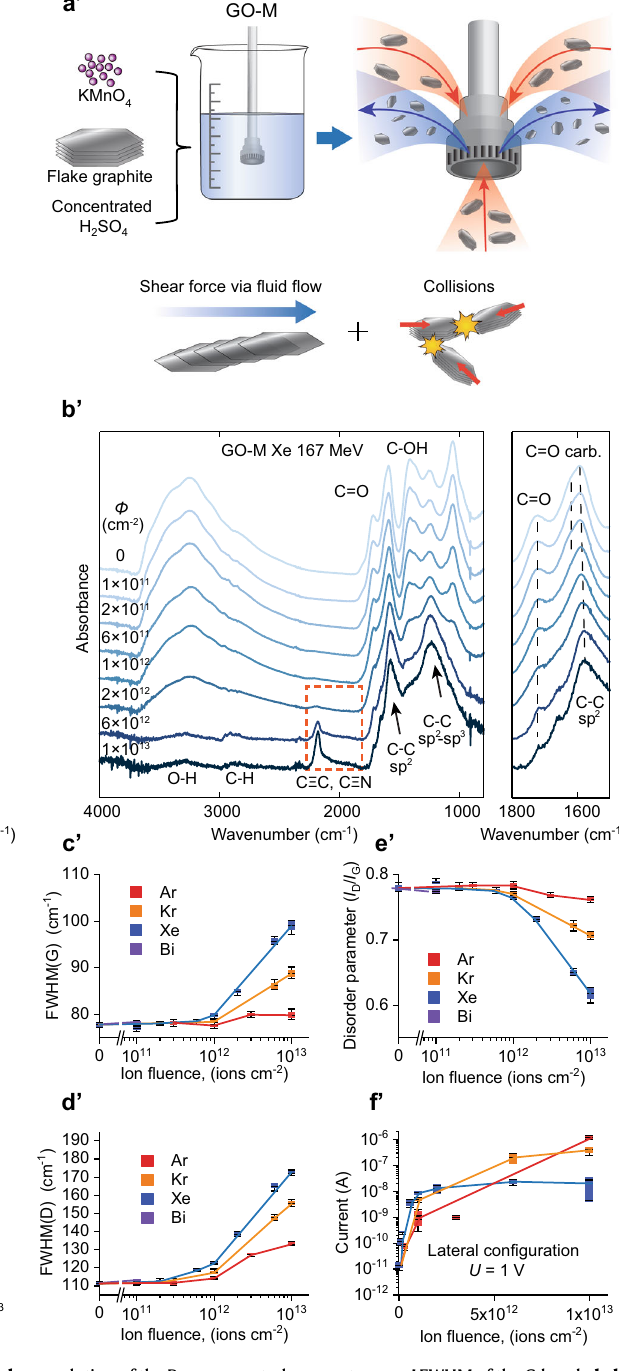
evolutionoftheRamanspectralparameters. c , c ’ FWHMoftheG-band, d , d ’ FWHM of the D-band, e , e ’ D- to G-band intensity ratio (disorder parameter) for GO fi lms irradiatedwithionsofdifferentelectronicstoppingpowers. f , f ’ Variationsinthein- plane conductivities (as the current recorded at a U of 1V) for GO fi lms irradiated with ions of different electronic stopping powers. In the plots: center line, mean value; box boundary, 95% con fi dence interval; whiskers, minimum and maximum. Source data are provided as a Source Data fi